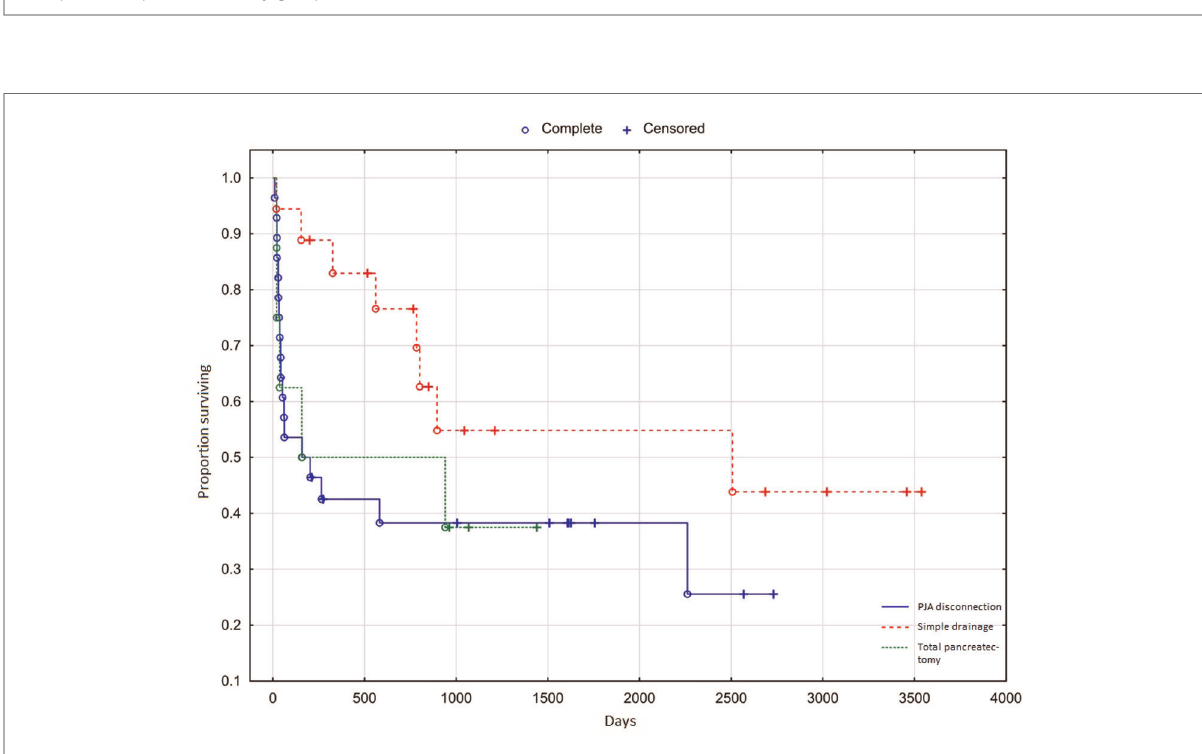
FIGURE 3 Overall survival of patients with Grade C postoperative pancreatic fi